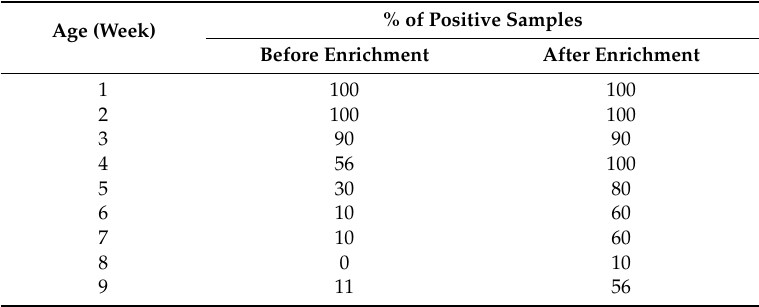
Table 1. Prevalence (%) of C. di ffi cile in the faecal samples from the o ff spring (suckling and weaned piglets) ( n = 8–10) sampled weekly from one until nine weeks of age. Faecal samples negative